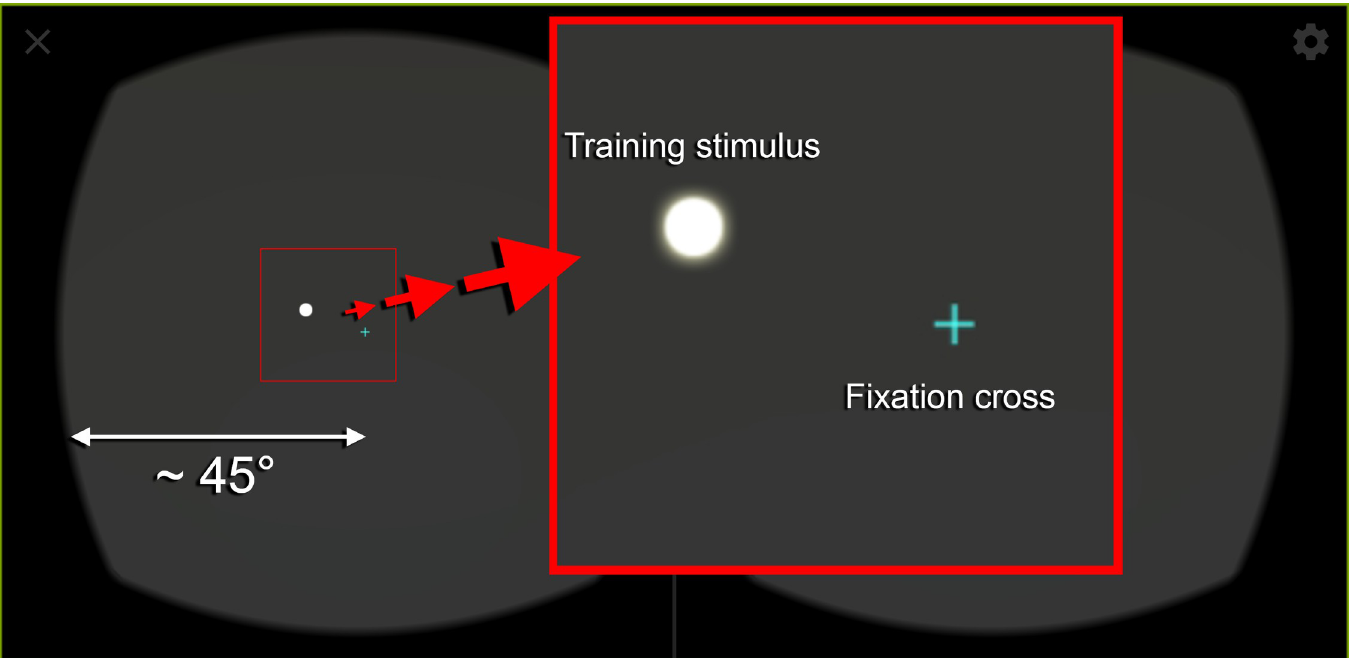
Fig 3. Exemplary stimulus presentation displayed during training with the “Salzburg Visual Field Trainer” (SVFT). Single bright stimuli are presented on a dark background with a centrally placed fixation cross. The digitally enlarged section (red square) shows the fixation cross—which the patients must fixate continuously during therapy sessions—and a training stimulus on an exemplary position in more detail. Based on system settings—which are configured by a qualified person and assessed e.g., with the help of the “Eye Tracking Based Visual Field Analysis” (EFA) beforehand—stimuli are displayed randomly along the user’s individual transition zones between intact and defect visual fields. The ZEISS 1 VR ONE Plus offers a stereoscopic field of view of approx. 90˚.